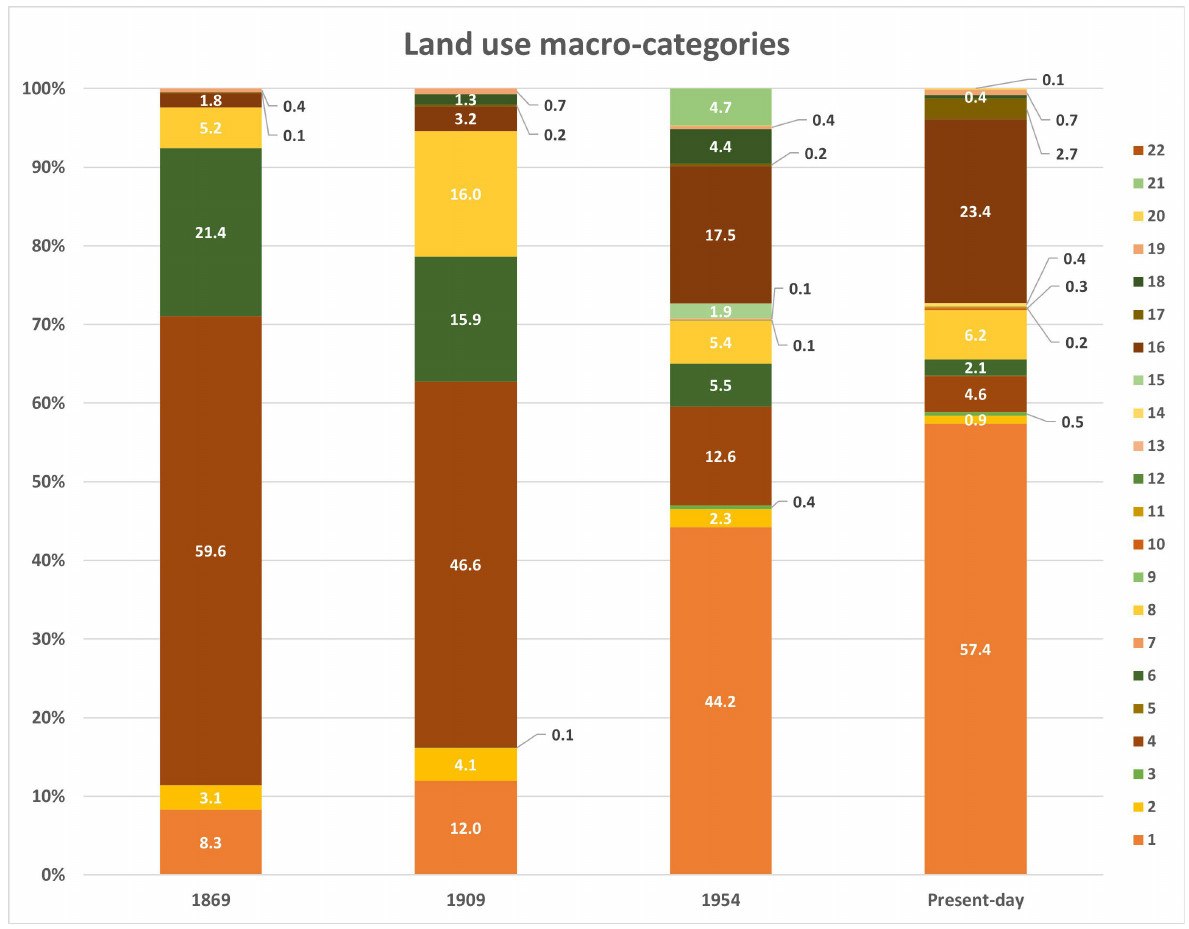
Figure 5. Land use categories are expressed as a percentage of the total investigated area in 1869, 1909, 1954, and present day. The numbers in the legend refer to the proposed land use macro-categories (cf. ID field in Table 3).